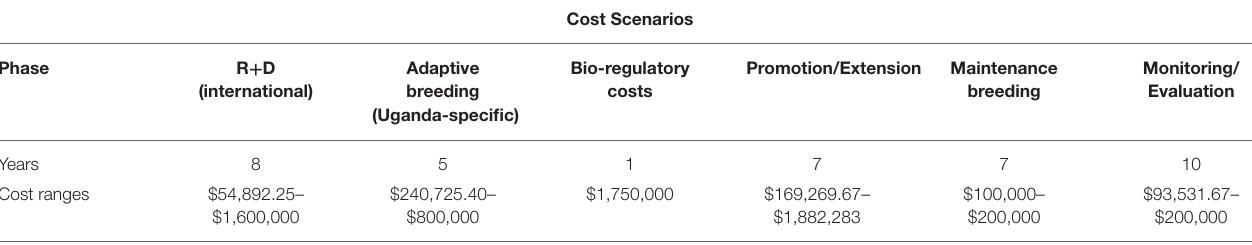
TABLE 1 | Cost components (ranges of estimated yearly costs in USD) and timeframe for both banana